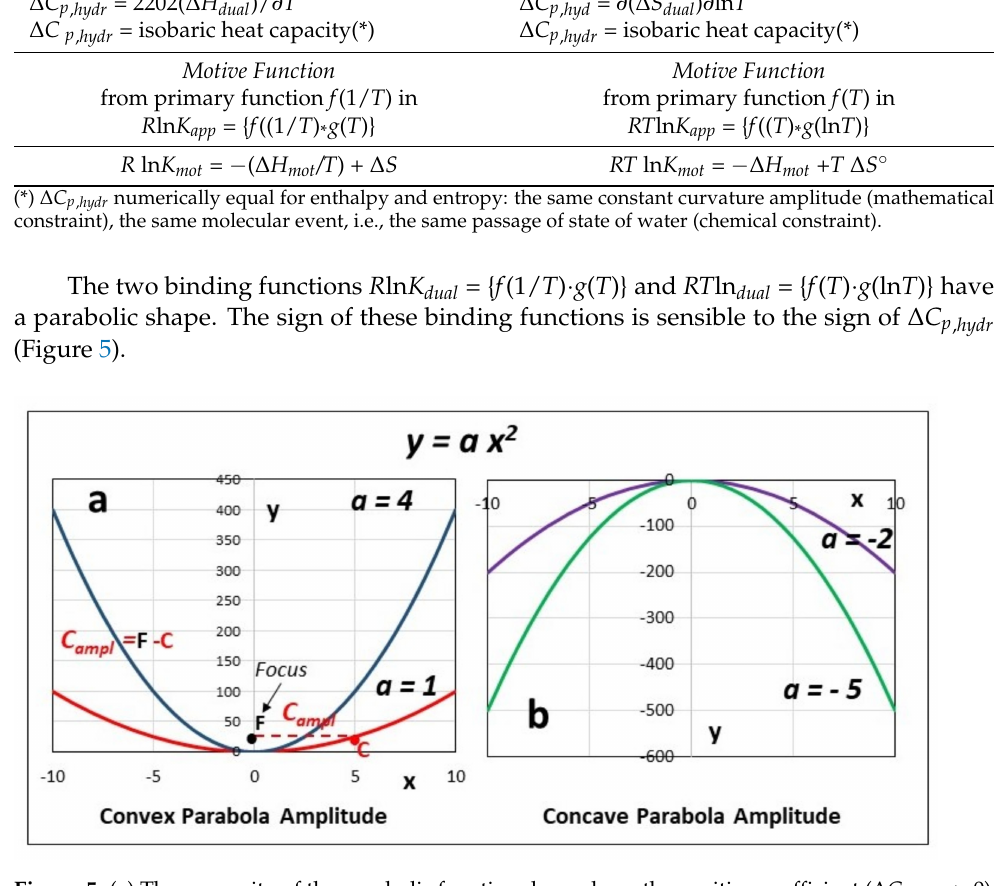
Figure 5. ( a ) The convexity of the parabolic function depends on the positive coefficient ( ∆ C p , hydr > 0); ( b ) The concavity of the parabolic function depends on the negative coefficient ( ∆ C p , hydr <